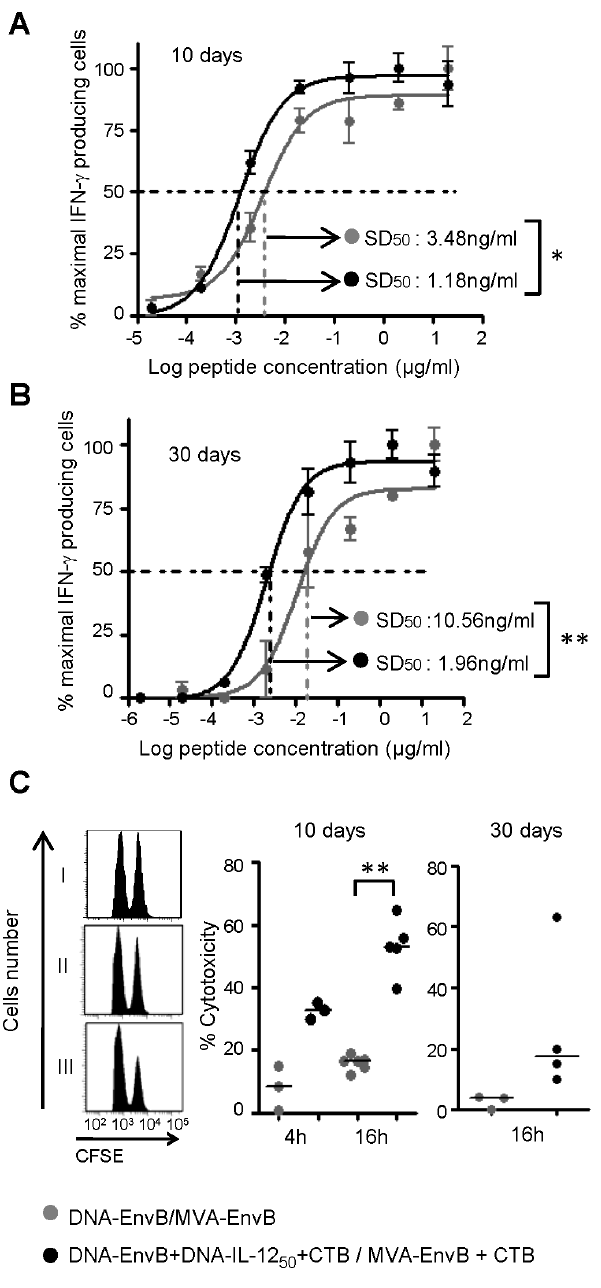
Figure 6. Study of T-cell functional avidity and in vivo T-cell specific killing activity. Pooled splenocytes from control and IL- 12 50 + CTB groups (three to six mice/group), were analyzed for functional avidity of the V3- loop specific T-cells at (A) 10 and (B) 30 days after immunization, by ELISPOT using serial dilutions of the peptide from 20 to 0.00002 m g/ml for triplicate wells. Data represents the average percentage of the maximal response. SD50: sensitizing dose of peptide required to yield 50% of maximal T-cell triggering IFN- c production. (C) In vivo cytotoxicity was analyzed adoptive transfer of control CFSElow and Env-peptide pulsed CFSEhigh dye cells. At 10 and 30 days after immunization, individual spleens of mice from naı¨ve (I), DNA-EnvB/ MVA-EnvB (II) and DNA-EnvB + DNA-IL-12 50 + CTB/MVA-EnvB + CTB (III) groups were analyzed at the indicated times after adoptive transfer. A representative histogram is depicted in the left panel. Dots represent each analyzed mice. Lines represent median Statistical differences between groups: *p , 0.05; **p , 0.01 by Mann-Whitney test.